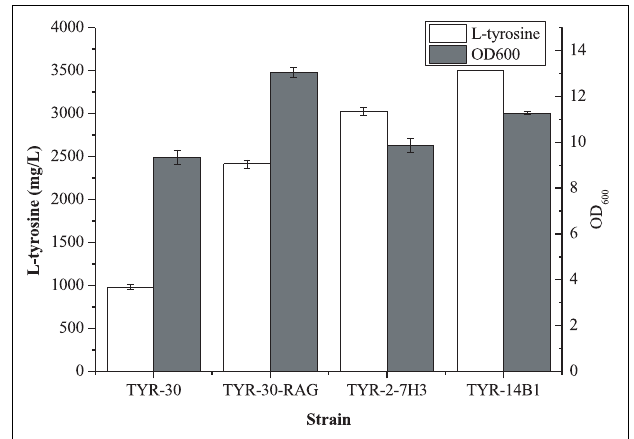
FIGURE 5 | Production of L-tyrosine of the selected E. coli strains. The data represent means of three replicates and error bars represent standard